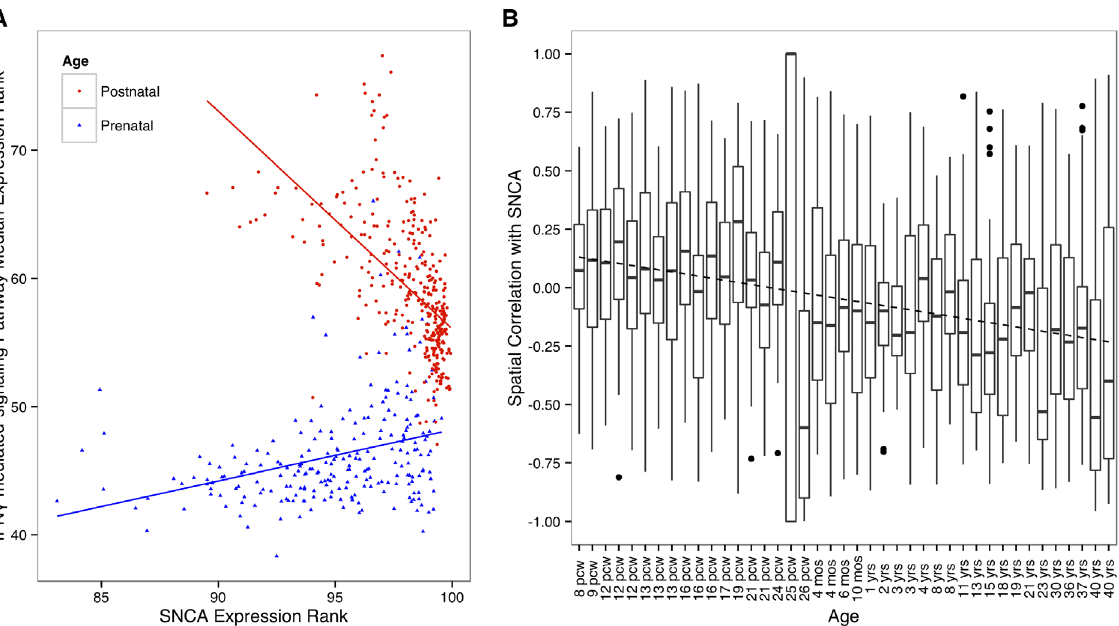
Fig. 2. Differential co-expression between IFN- c genes and SNCA across age. A) Scatterplot of SNCA and IFN- c -mediated-signaling pathway median expression in prenatal (red triangles, n 5 232) and postnatal samples (blue circles, n 5 345). High rank corresponds to high expression. An outlier prenatal sample with low SNCA expression of 16524 was excluded to improve plotting. B) Boxplots showing spatial correlation of the 73 IFN- c genes against SNCA within each BrainSpan donor. The 25 pcw (postconception weeks) fetus has only two sampled brain regions which results in a Spearman correlation of 2 1 or